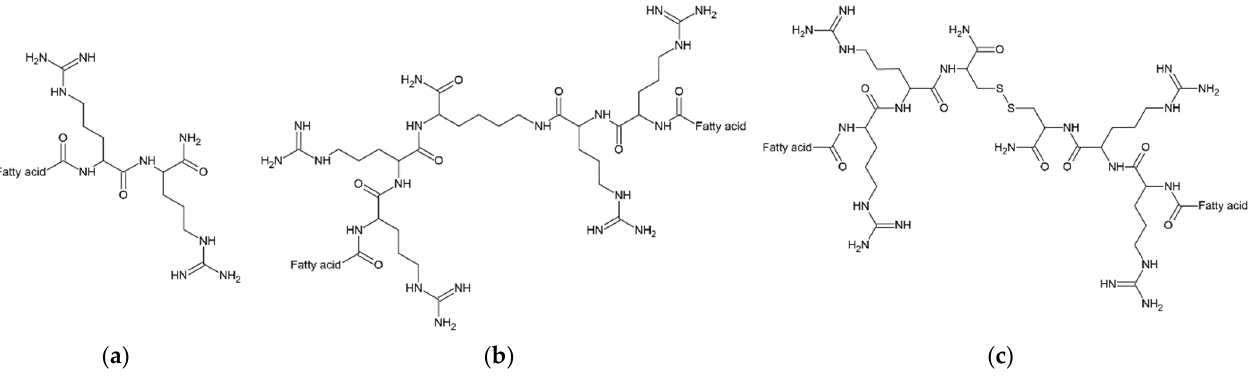
Figure 3. General structures of lipopeptides: ( a ) USCL—parent molecules; ( b ) gemini lipopeptides with L-lysine amide spacer; ( c ) gemini lipopeptides with L -cystine diamide spacer. Compounds B5 , B6 , C5 , and C6 have N-terminal phenylalanine (Phe) or norleucine (Nle) residues, while B7 and C7 have 2-butyloctanoic acid residues denoted as C8(4). Structures of B5–B7 and C5–C7 are attached as Supplementary Materials, Figures S1–S6. USCL: ultrashort cationic lipopeptides.